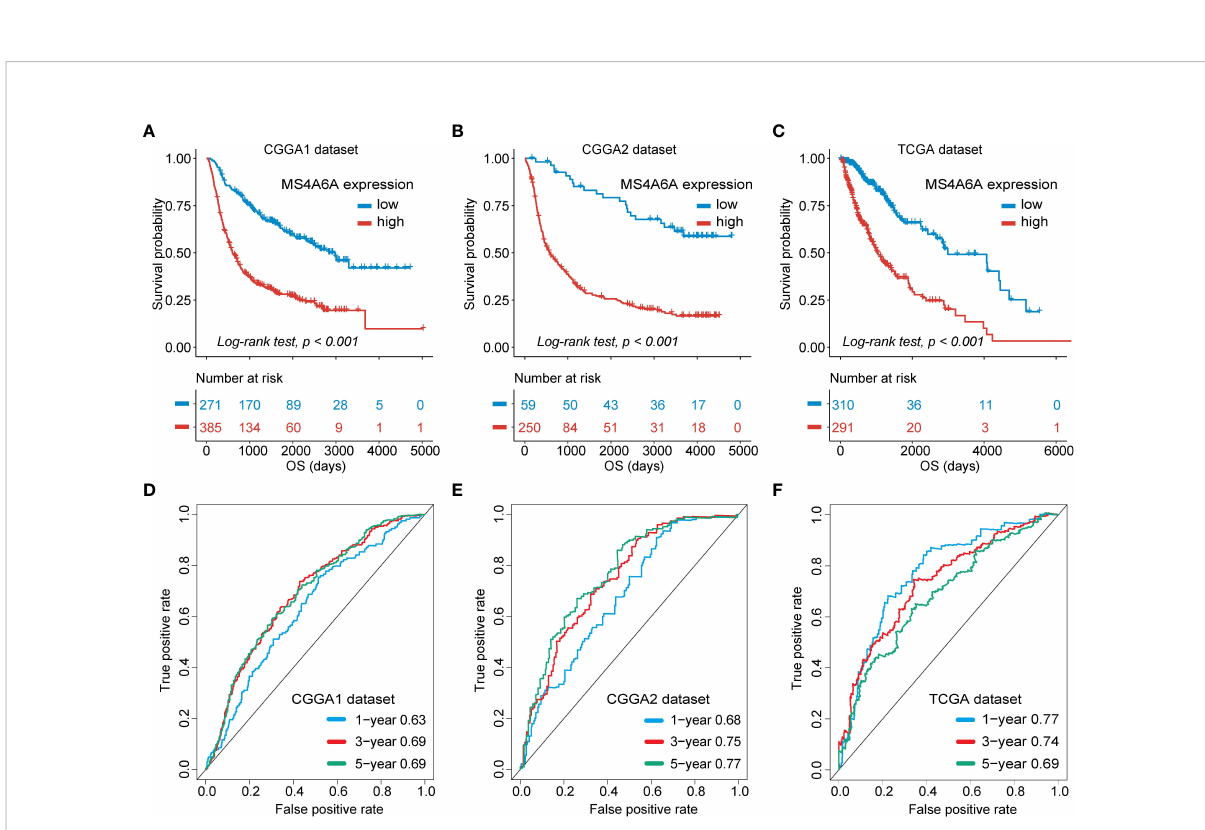
FIGURE 3 Survival analysis of MS4A6A expression and prediction accuracy assessment.Kaplan – Meier curves of survival differences between MS4A6A subgroups in the CGGA1 set (A) , CGGA2 set (B) , and TCGA set (C) . ROC curves calculating the predictive accuracy of MS4A6A in the CGGA1 set (D) , CGGA2 set (E) , and TCGA set (F) for OS at 1, 3, and 5